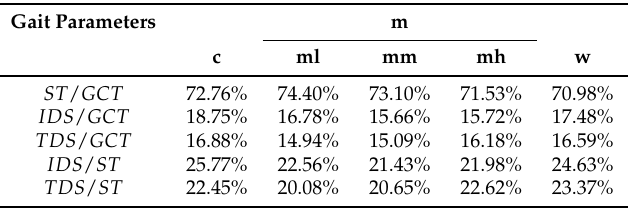
Table 6. The ratio of stance time ( ST ), initial double support ( IDS ), and terminal double support ( TDS ) in a gait cycle.